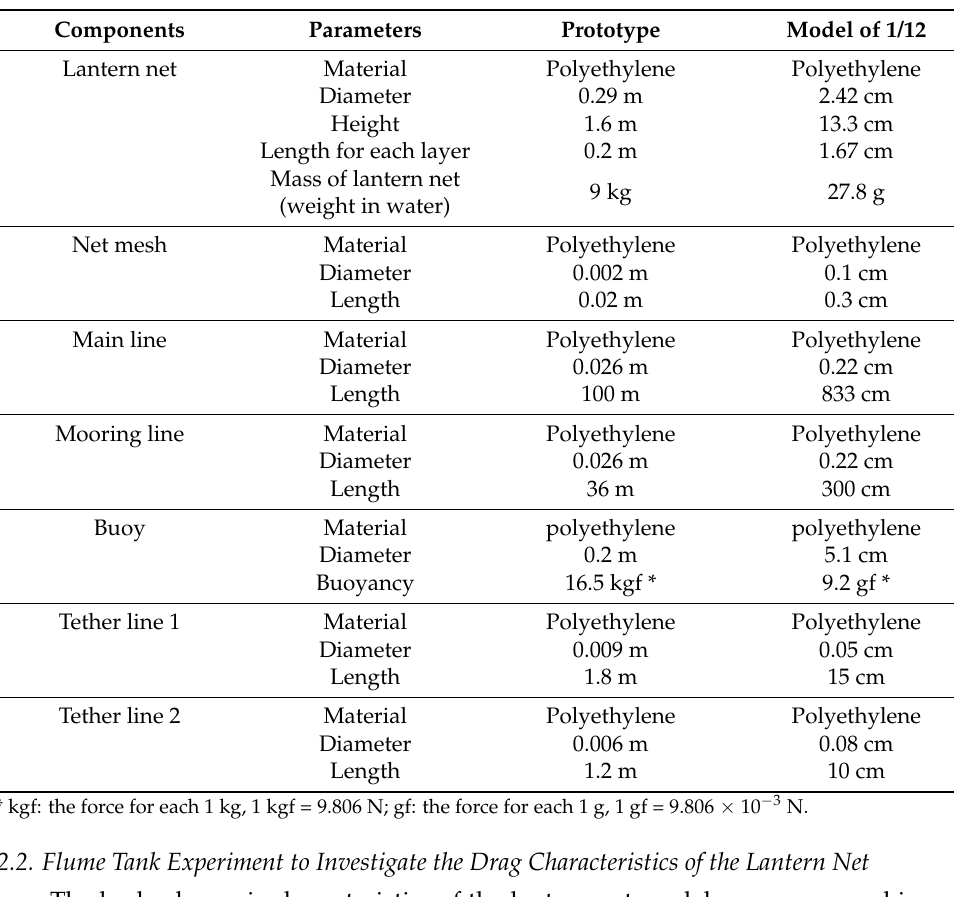
Table 1. Configurations of prototype and model of longline aquaculture facility with lantern nets.